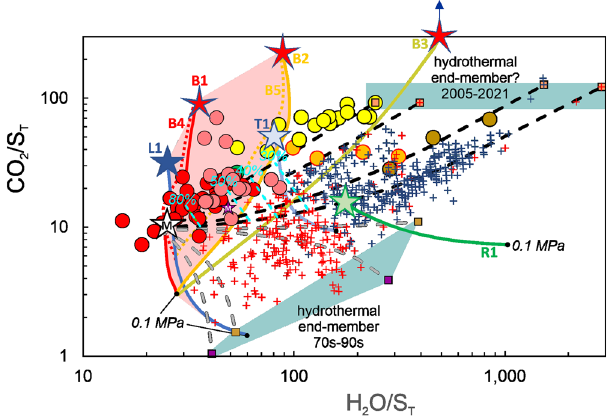
Fig. 8 Resolving hydrothermal vs. magmatic gas contributions. A scatter plot of H 2 O/S T vs. CO 2 /S T ratios in La Fossa fumaroles (from direct sampling; crosses, symbols as in Fig. 4) and in their near-vent atmospheric plumes (from Multi-GAS, data from Supplementary Table 2; circles, symbols as in Fig. 4). The October – December 2021 La Fossa fumarolic plumes cluster in a compositional band overlapping the magmatic gas fi eld (red coloured area) delimited by the B1/B4, B2/B5 and L1 model degassing trends (curves as in Fig. 4). The positive H 2 O/S T vs. CO 2 /S T relationship, exhibited by the October-December 2021 datapoint array (Fig. 8), implies some extent of mixing with hydrous (and S-poor) hydrothermal fl uids. The magmatic gas mixing proportion (green dashed lines) are estimated at 30 – 100% by resolving mixing (mixing curves shown as dashed back lines) relationships between a magmatic gas end-member (white star M; calculated averaging the composition of the most H 2 O-poor Multi-GAS data) and a possible set of hydrothermal end-members (orange squares; identi fi ed using the gas samples with the most extreme H 2 O-rich compositions). Grey dashed lines illustrate mixing between the magmatic gas end-member M and the 1970s – 1990s hydrothermal gas end-members identi fi ed by ref. 36 (purple squares) and ref. 48 (golden squares). The blue- coloured fi elds thus identify the potential compositional fi elds of the hydrothermal component(s) in the 1970s – 1990s and 2005 – present.